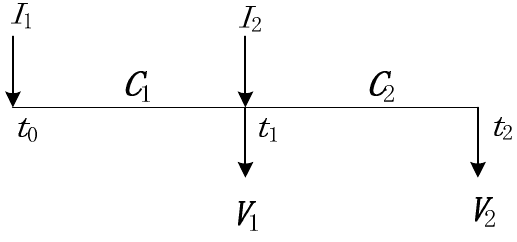
Figure 4. Two-stage compound real options framework.